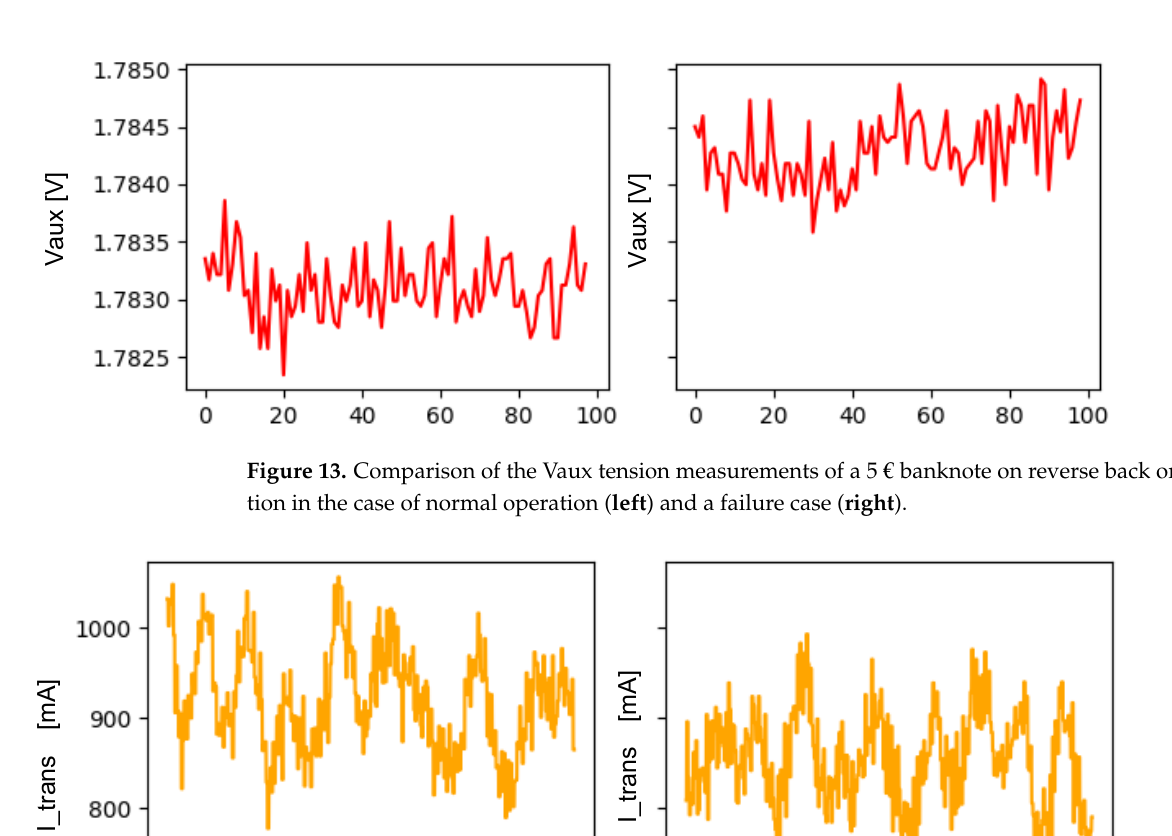
Figure 14. Comparison of the measurements of the transport motor current of a 50 € banknote on reverse front orientation in the case of normal operation ( left ) and that of a failure case ( right ).